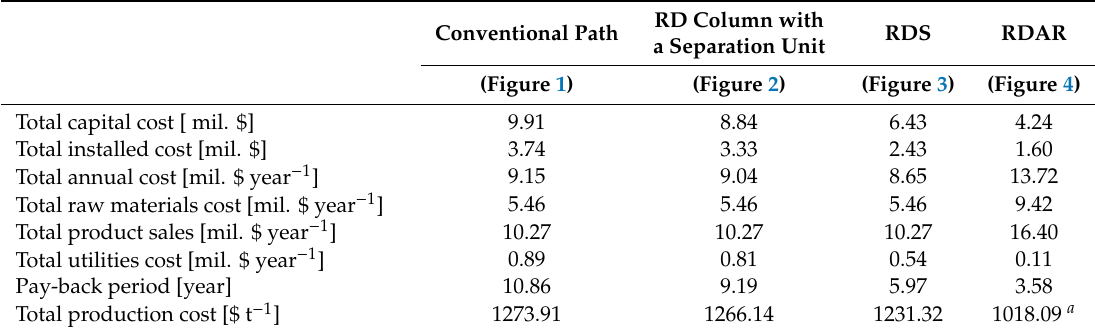
Table 12. Total annual costs of individual case studies. Conventional